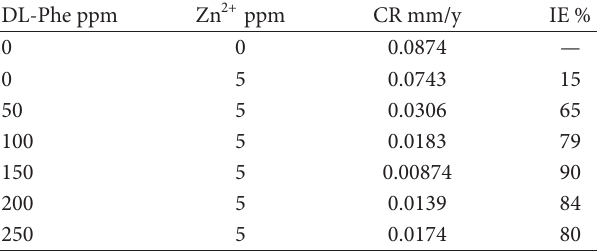
F 1: Polarization curves of carbon steel immersed in